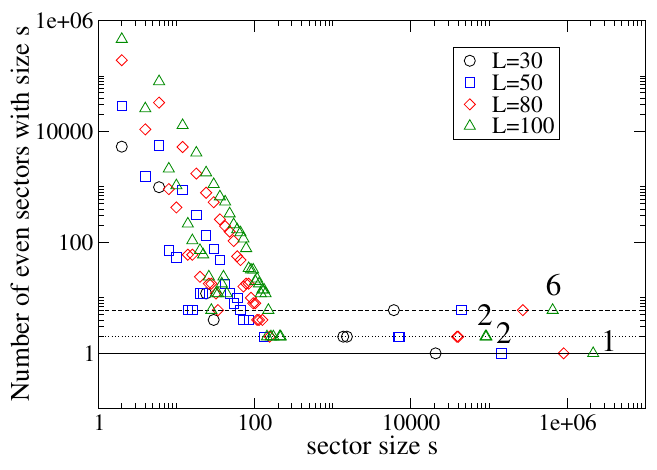
Figure 3: Distribution of sizes of even sectors of dynamics II for various linear sizes L (logarithmic scales). We note a numerous number of small sectors and 11 large sectors, with a clear separation between the two.